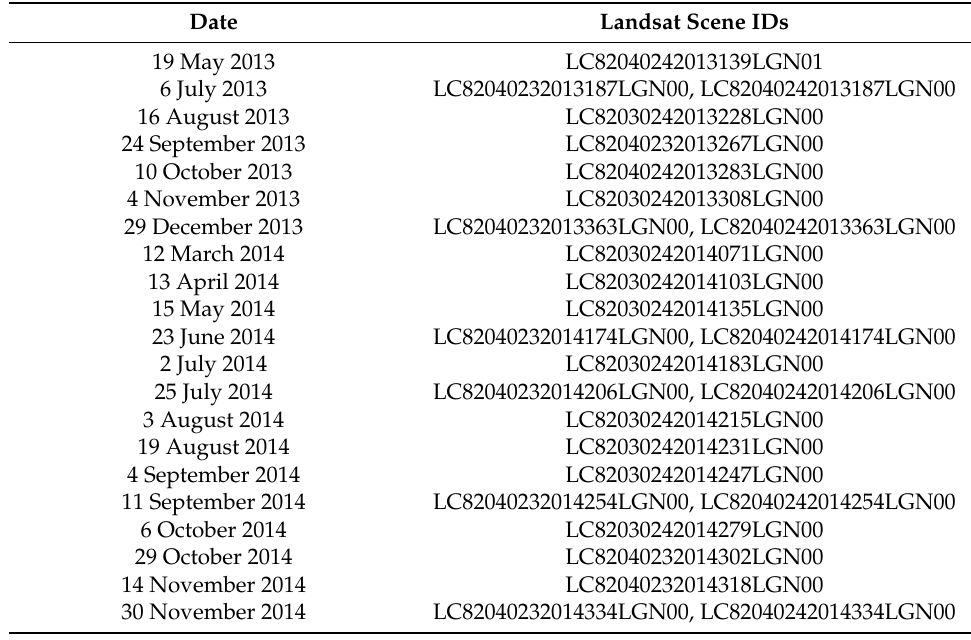
Table 1. List of Landsat 8 OLI scenes used in this